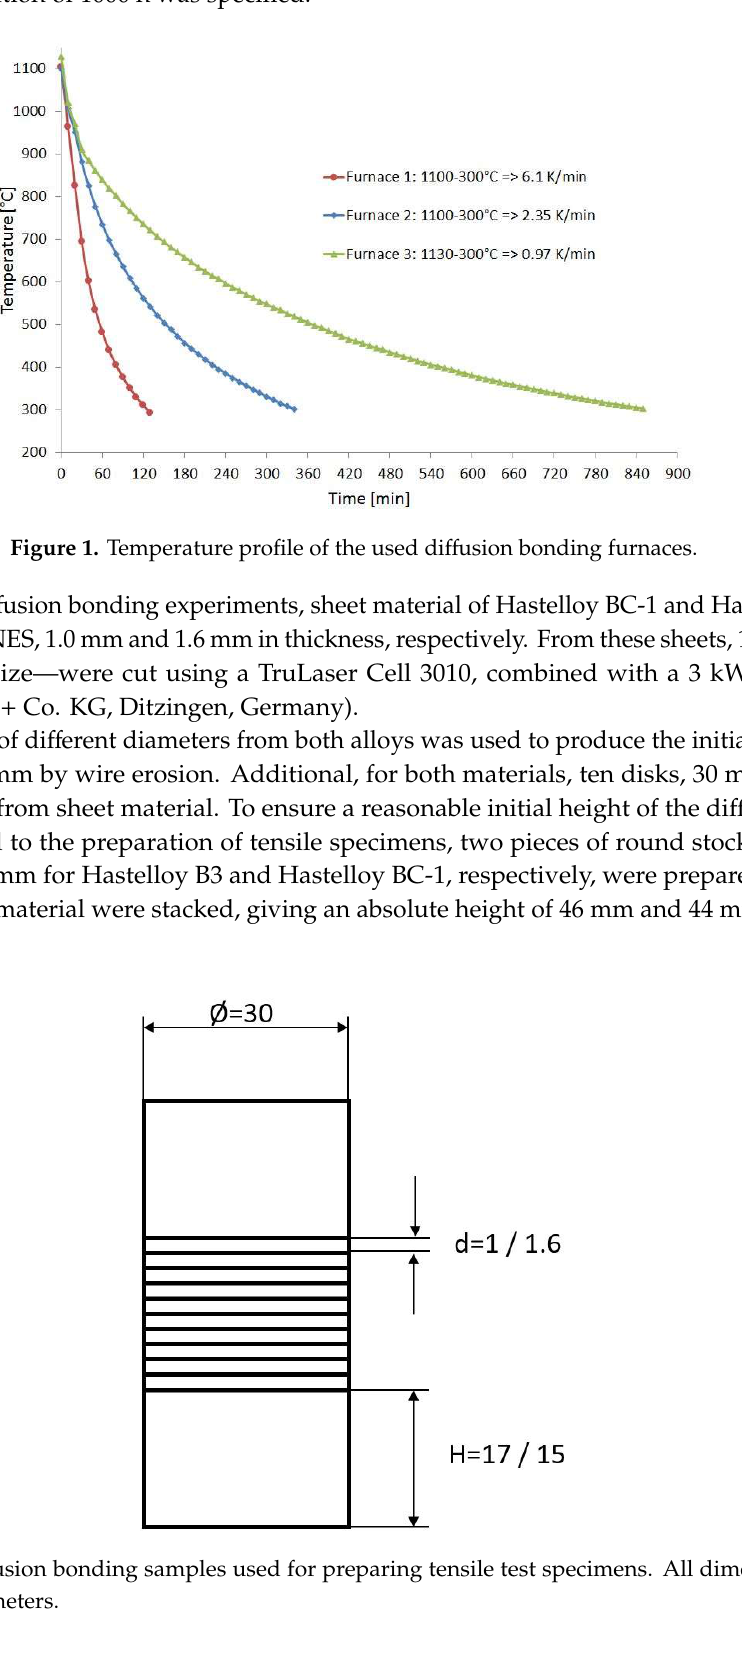
Figure 2. Diffusion bonding samples used for preparing tensile test specimens. All dimensions are given in